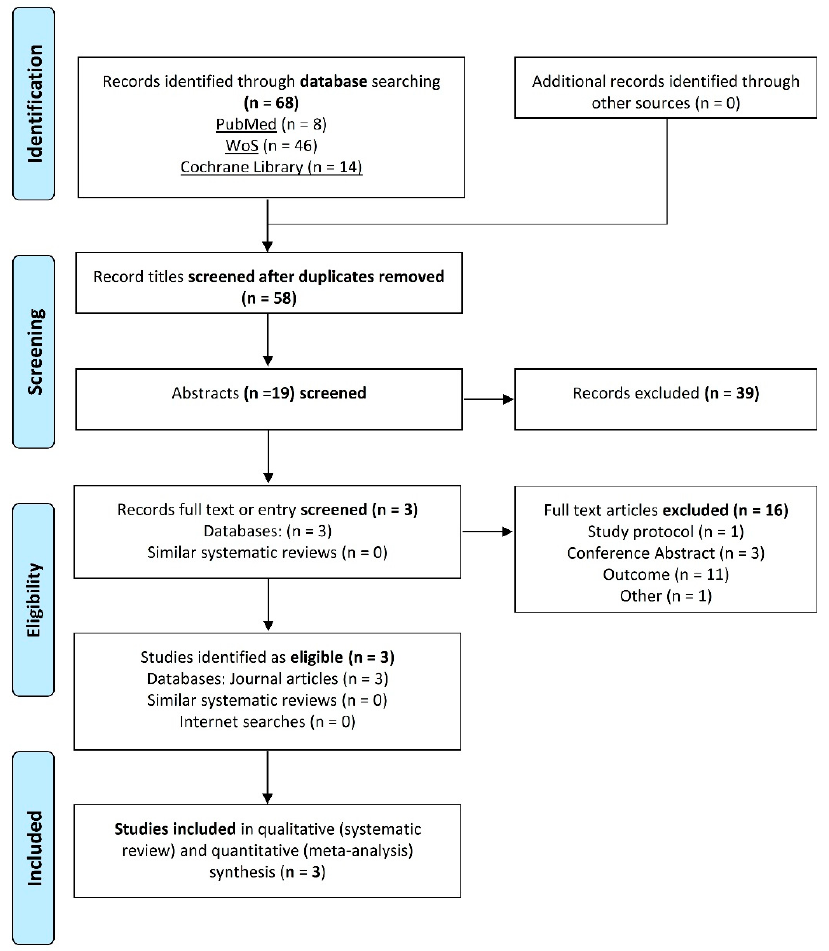
Figure 1. PRISMA flow diagram illustrating the selection process of included studies.